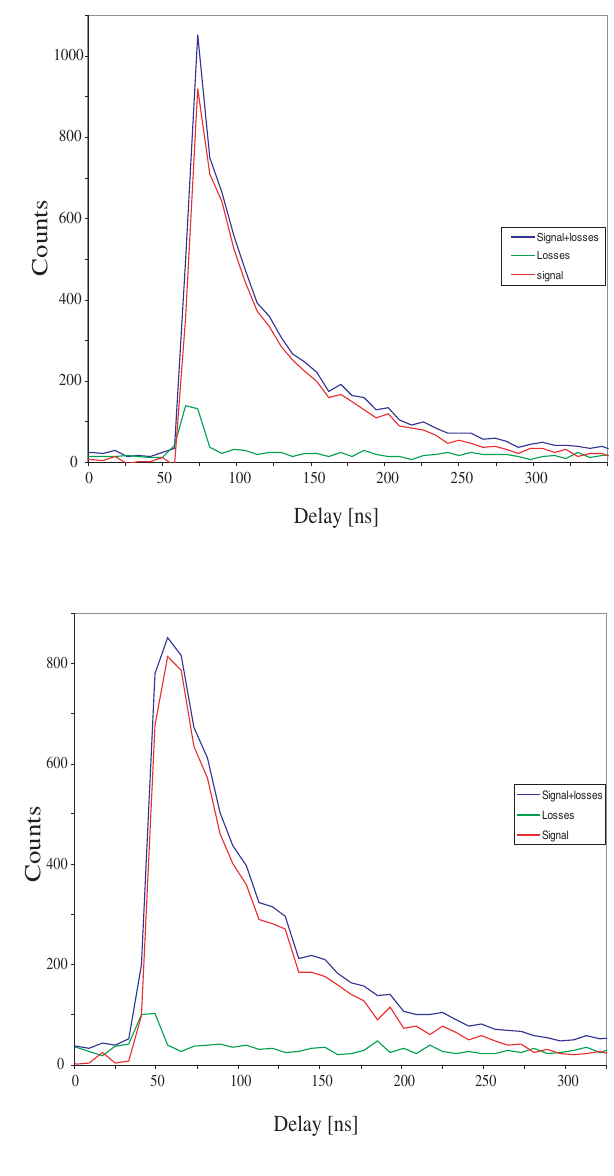
FIG. 13. (Color) Decay time measurements performed with two different bunch lengths. Case 1 is for the nominal bunch; case 2 corresponds to a longer